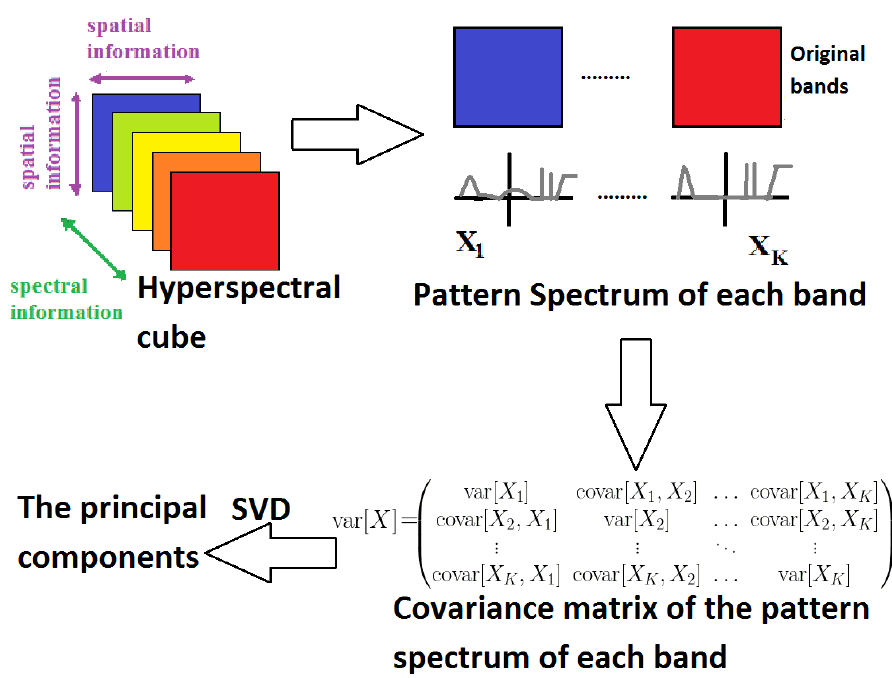
Figure 6. Process of pattern spectrum MorphPCA.